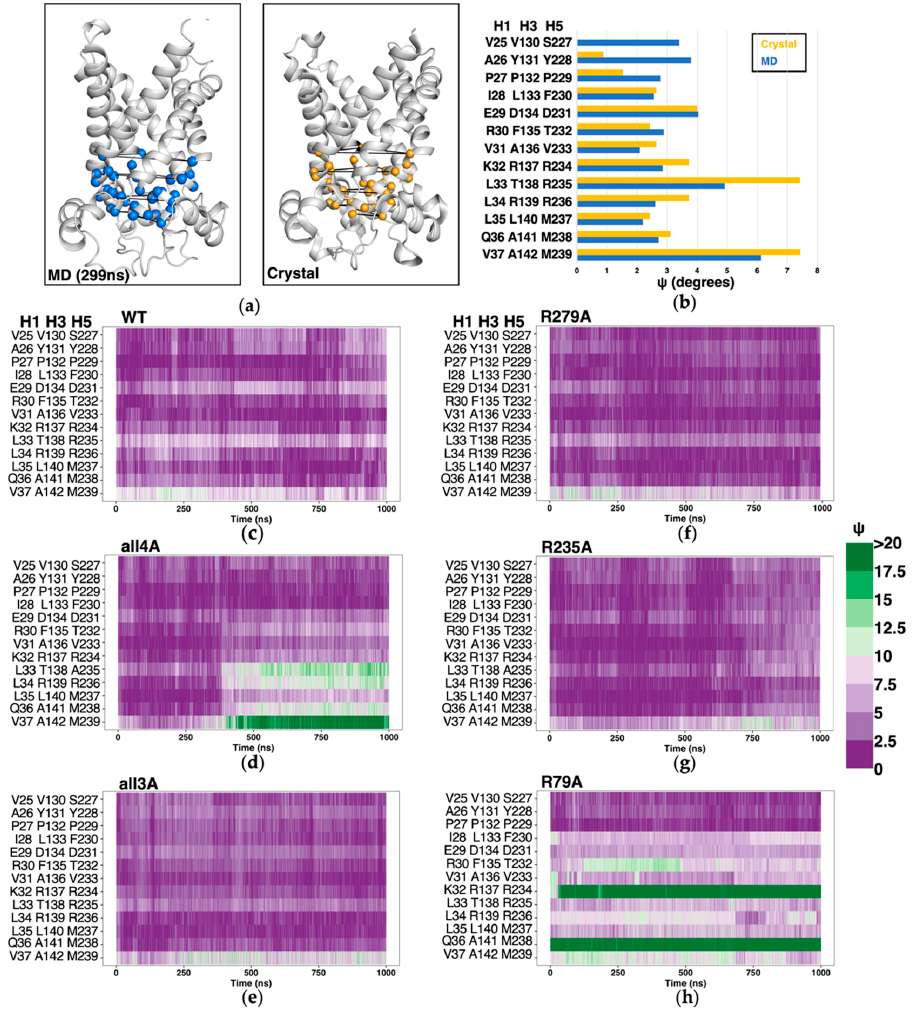
Figure 8. Geometrical symmetry around the m-gate level in c-state AAC. ( a ) The model used to calculate deviations from the C 3 -symmetry score. The triplets used for calculation are shown in spheres. ( b ) The average ψ values of the wild-type simulation structure and crystal structure of c-state AAC (PDB: 1OKC). ( c–h ) Time evolution of the geometric symmetry analysis in wild-type AAC and the five mutants. Gradient colors are used to indicate the extent to which each plane deviates from C 3 -symmetry.